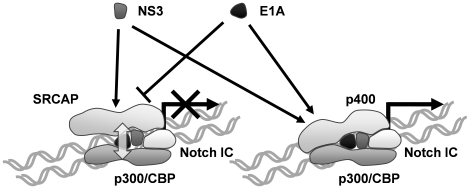
Proposed mechanism of HCV NS3 and adenovirus E1A in the Notch-mediated transcription.The HCV NS3 protein activates both the SRCAP and p400 functions for the Notch-mediated transcription, whereas adenovirus E1A protein activates only the p400 function. Since E1A disrupts the interaction of p300 and p400, enhancement of SRCAP-mediated transcriptional activation of Notch target genes by NS3 is inhibited by the competition with the E1A function. The NS3 function for p400-mediated transcriptional activation is not competitive with the E1A function. Thus an additional expression of NS3 enhances the E1A function for increments in the p400-mediated transcriptional activation.